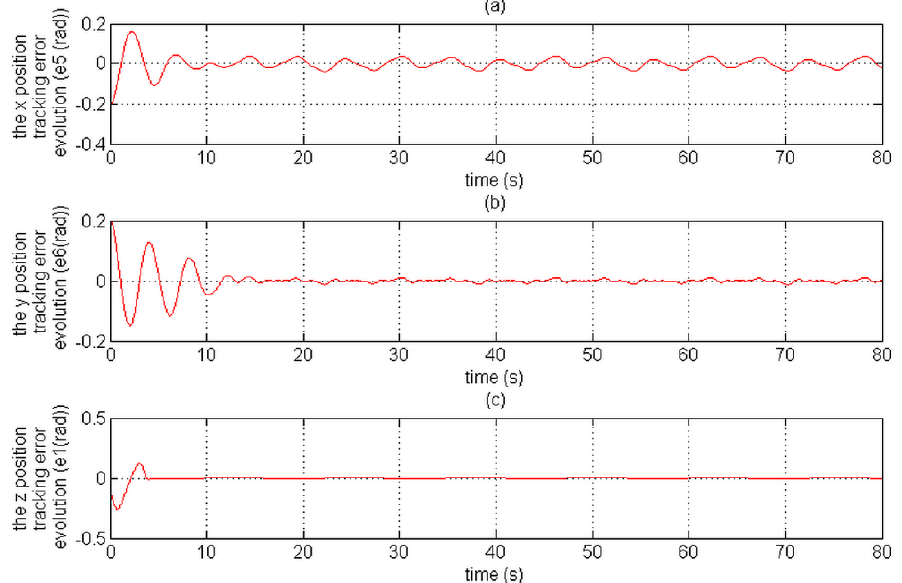
Figure 16. The position tracking errors obtained by the CMTC: ( a ) x -position error (m); ( b ) y -position error (m); ( c ) z -position error (m).